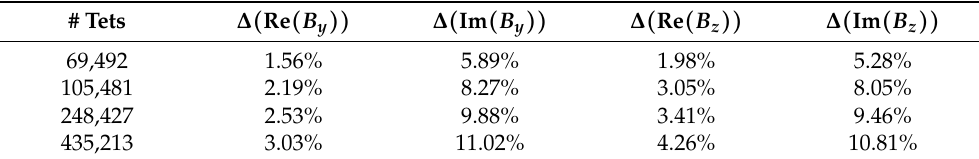
Table 11. Discrepancy between 3D CM–BEM with ACA compression and second order 3D FEM. # Tets